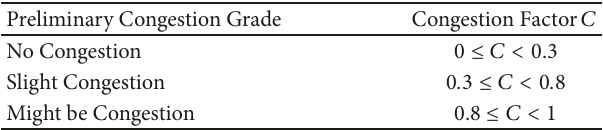
Table 2: Preliminary result of congestion grade based on road